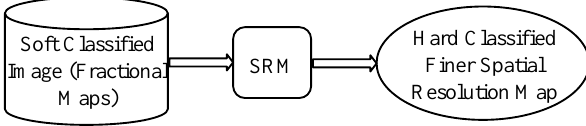
Figure 1. The overall procedure of SRM